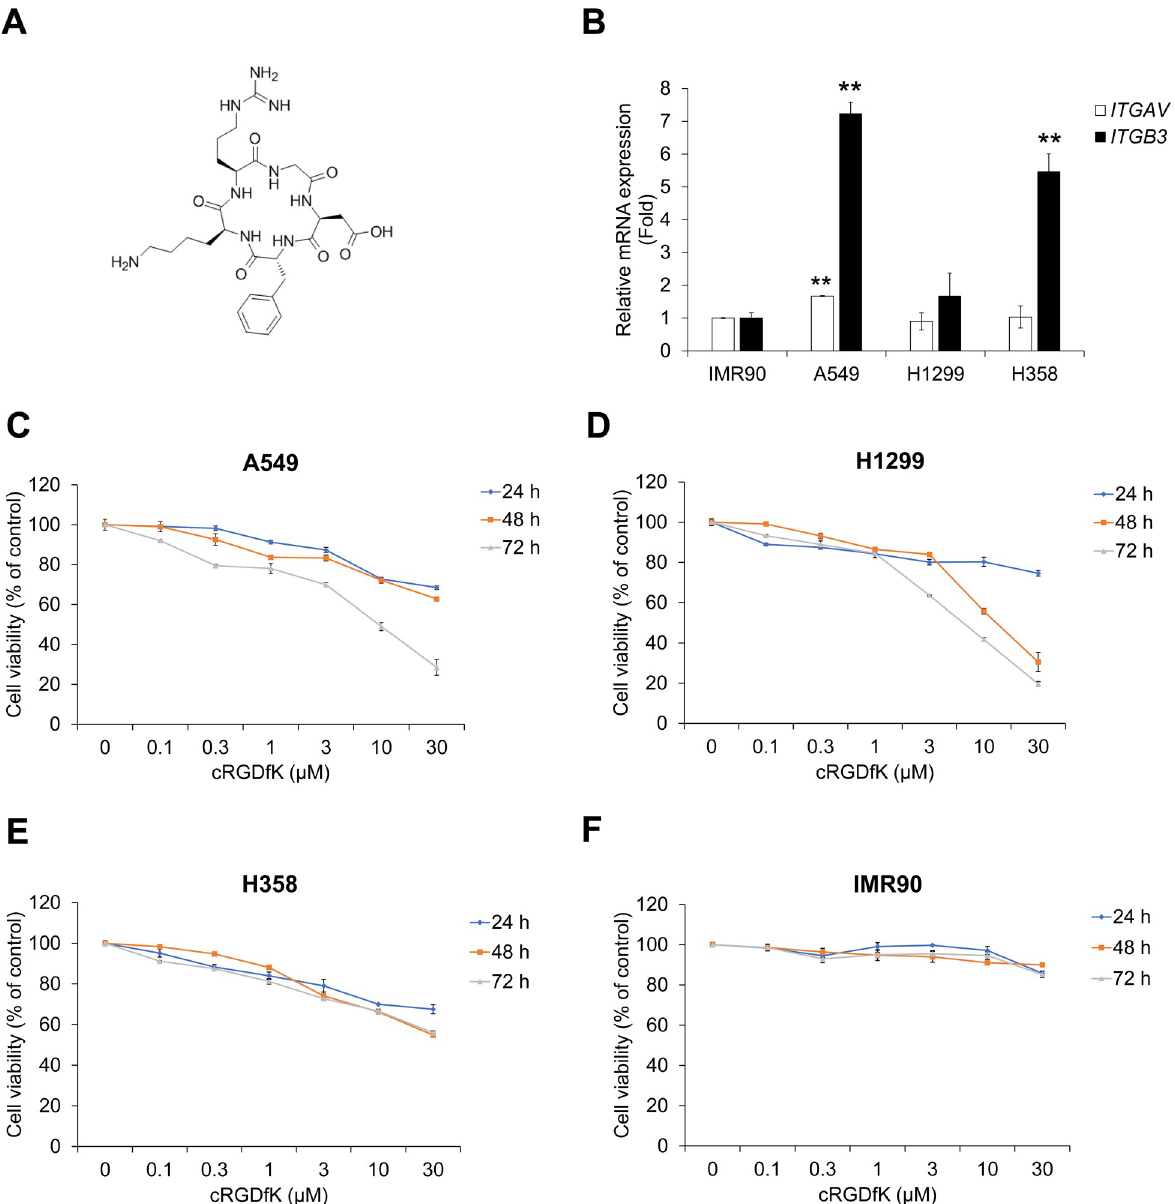
Fig 5. Treatment with cRGDfK inhibits proliferation of human NSCLC cells. (A) Chemical structure of cRGDfK. (B) The relative mRNA expression of integrin α Ⅴ and β 3 in human NSCLC cells. (C–F) NSCLC A549 (C), H1299 (D), and H358 (E) cells and normal fibroblast IMR90 cells (F) were treated with cRGDfK for 24–72 h. After incubation, cell viability was measured by CCK-8 assay. Experiments were performed in triplicate. Data represent the mean ± SD of raw